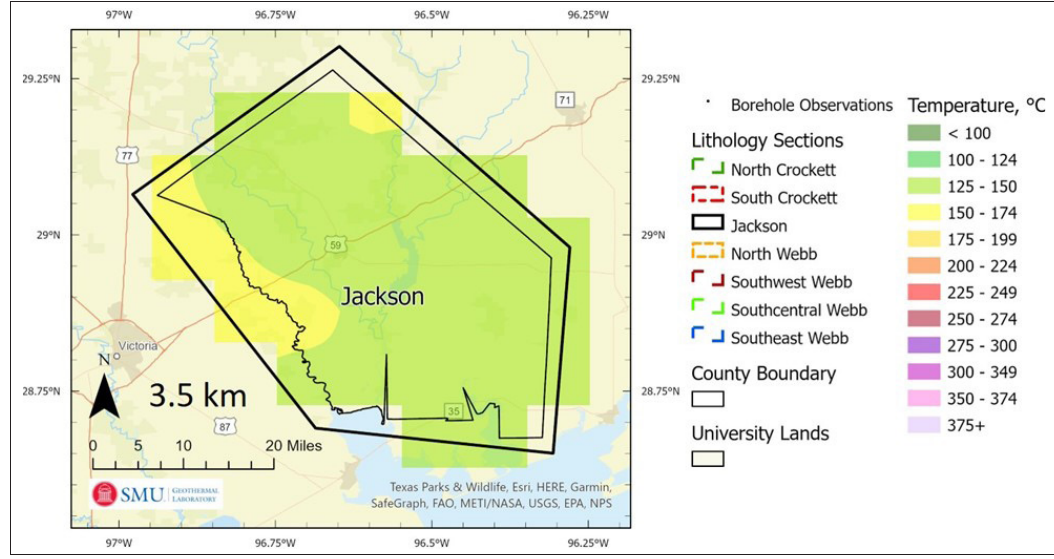
Figure 8. Temperature at 3.5 kilometers (km; 11,500 feet) depth in Jackson County. Higher temperatures are mapped along the western boundary and near the northern corner of the county. One county lithology cross-section was